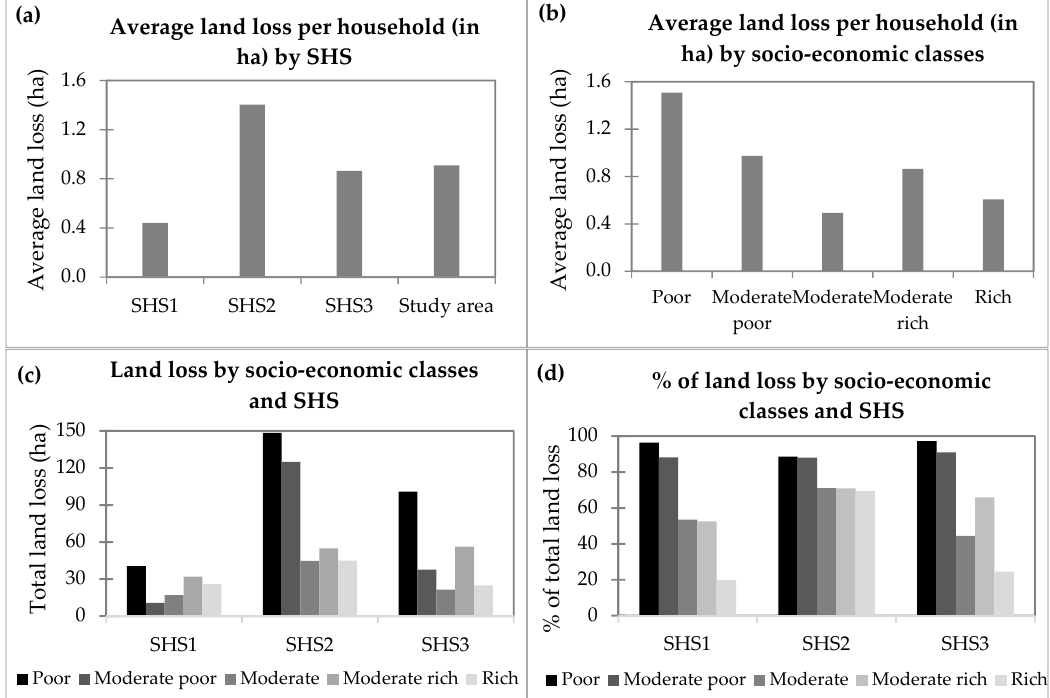
Figure 7. Total land loss by SHS and economic classes in the study area from 1962 to 2016. ( a ) Average land loss per household (in ha) by SHS; ( b ) Average land loss per household (in ha) by socio-economic classes; ( c ) Land loss by socio-economic classes and SHS; ( d ) % of land loss by socio-economic classes and